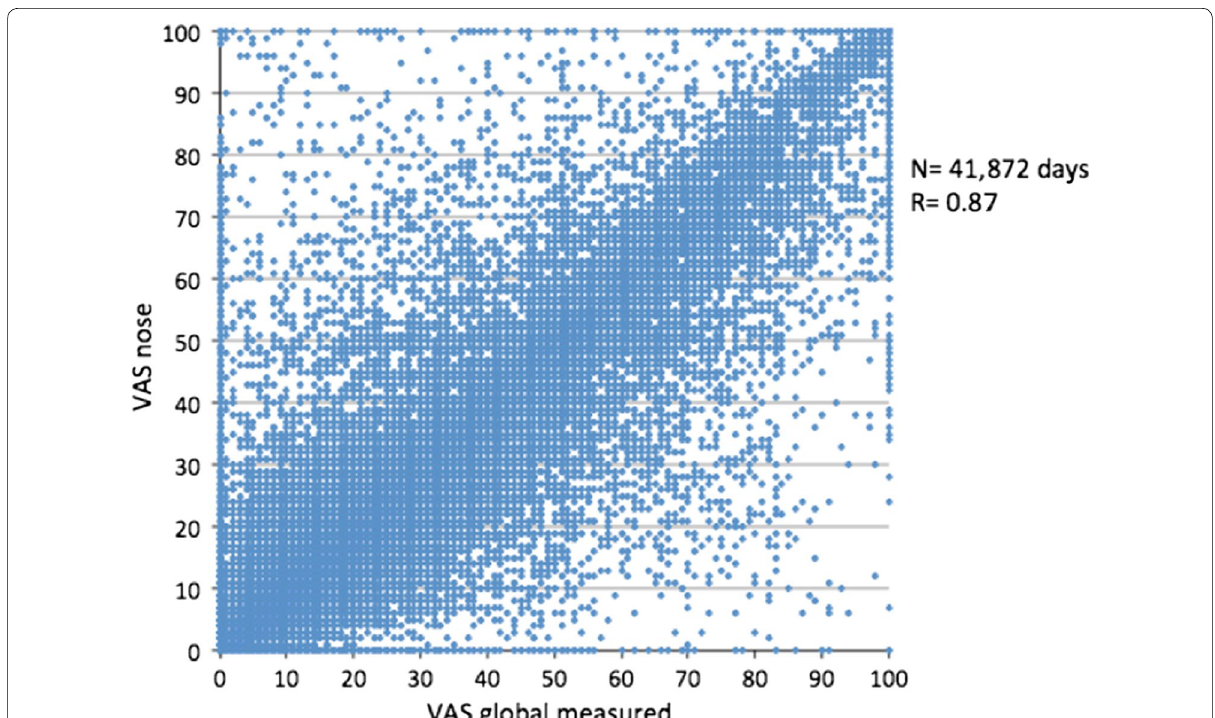
Fig. 2 Correlation between Visual Analog Scale (VAS) global measured and nasal symptoms (VAS nose)